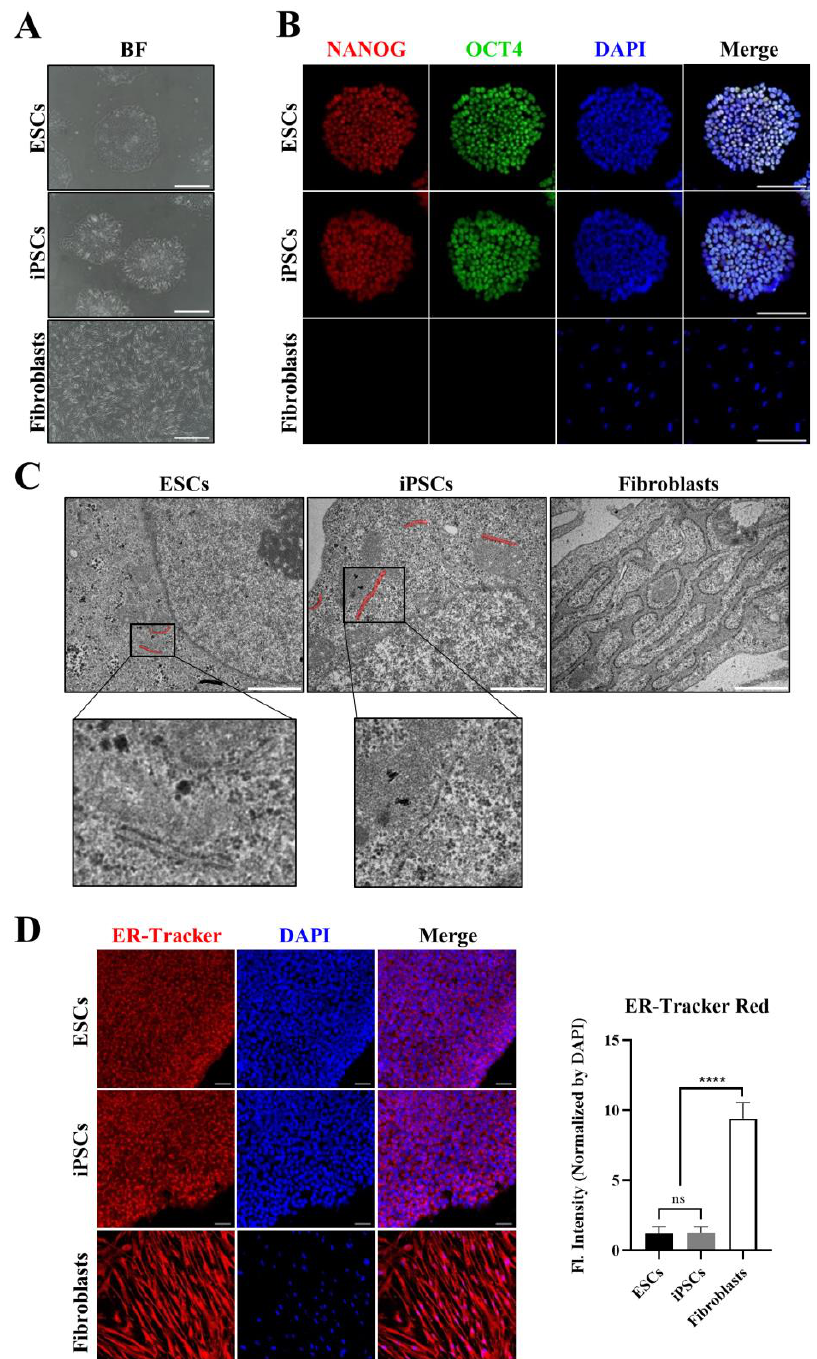
Figure 1. Morphological di ff erences of the endoplasmic reticulum (ER) in human pluripotent stem cells (hPSCs) and fibroblasts. ( A ) Bright field (BF) image showing cultured cells before harvesting for transmission electron microscopy (TEM) analysis. Scale bar: 200 µ m ( B ) Immunostaining showing the expression of NANOG (red fluorescence) and octamer-binding transcription factor 4 (OCT4 as known POU5F1) (green fluorescence) in hPSCs. Scale bar: 150 µ m ( C ) TEM images showing the ER structure of each sample. Red bar indicates the ER in hPSCs. The small images show enlarged ER. Scale bar: 1 µ m. ( D ) Confocal microscopy images showing the ER tracker signal that binds to ER. Fluorescence intensity graph indicate that 4′,6-diamidino-2-phenylindole (DAPI) normalized ER tracker signal. Scale bar: 50 µ m. Values represent the mean ± SD. Tukey’s t test: **** p < 0.00001; “ns” represents non-significant di ff